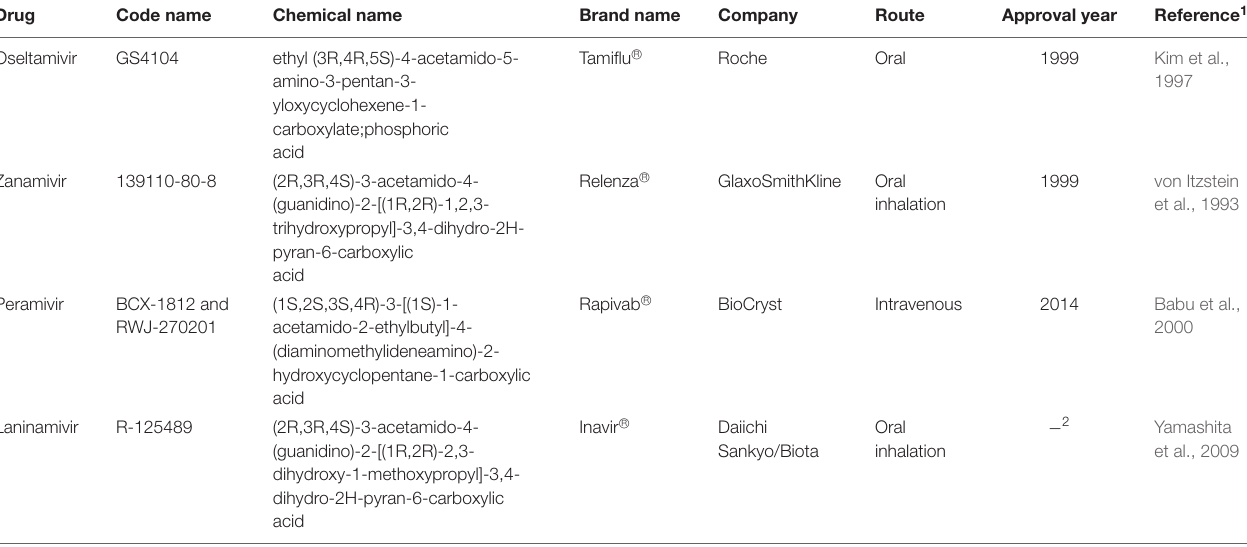
TABLE 1 | Neuraminidase inhibitors currently approved or undergoing clinical trials for treatment and prophylaxis against influenza. Drug